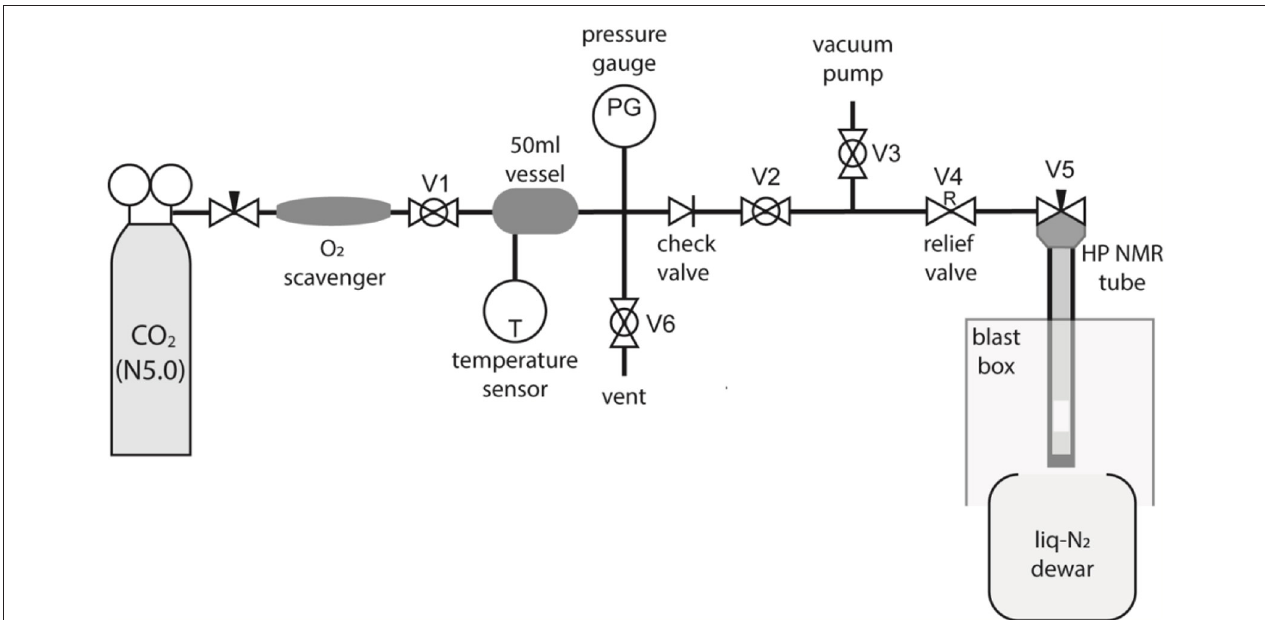
FIGURE 3 | A diagram of the custom-made CO 2 filling station built to fill high-pressure NMR tubes with liquid-CO 2 . sample, we have inserted 7.9 mg of Nap (MW = 426.36 g mol − 1